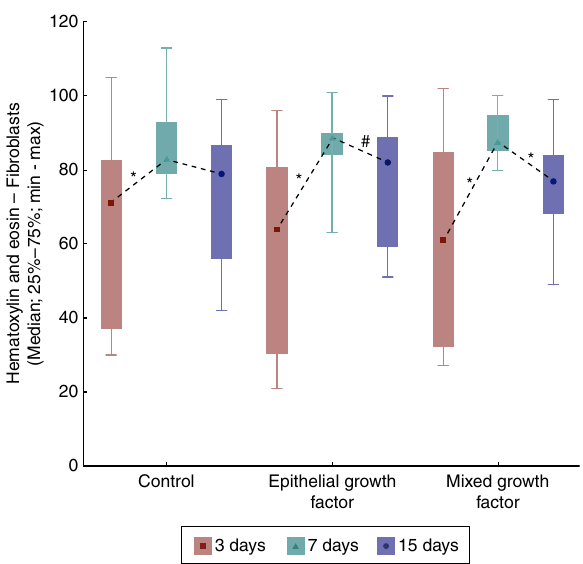
Figure 6 Hematoxylin and eosin evolution --- fibroblasts in each wound, between the times of euthanization, assessment between groups.